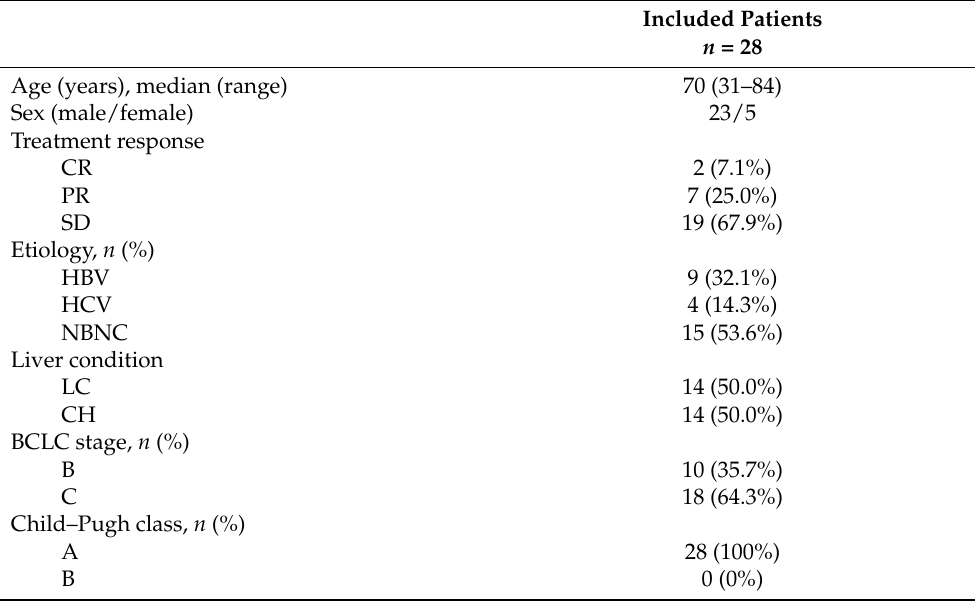
Figure 4. Changes in the growth factors between the baseline and best overall response points ( n = 32). Serum median VEGF-A, VEGF-C, VEGF-D, FGF-19, HGF, ANG-2, and EGF levels were compared between the baseline and best overall response points in all cohorts. The bar graph shows the median serum growth factor levels with an interquartile range indicating the error bars. Asterisks indicate statistically significant differences (* p < 0.05, **** p < 0.0001). ns, not significant. VEGF, vascular endothelial growth factor; FGF-19, fibroblast growth factor-19; HGF, hepatocyte growth factor; ANG-2, angiopoietin-2; EGF, epidermal growth factor; BOR, best overall response. Table 3. Baseline characteristics of patients who experienced PD after CR, PR, or SD with atezolizumab plus